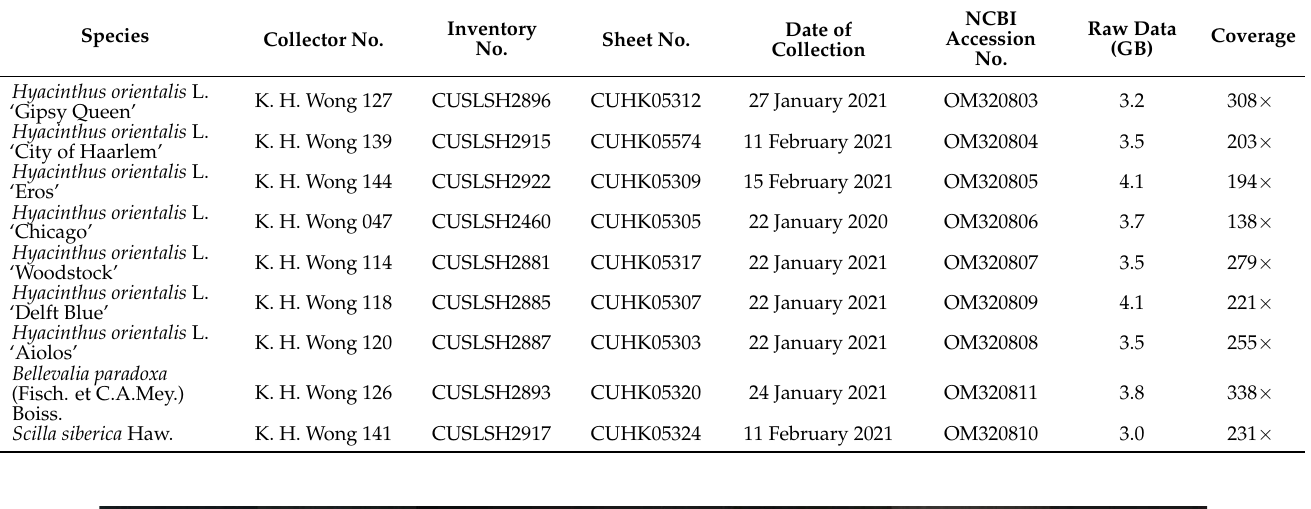
Table 1. Information of the studied specimens.